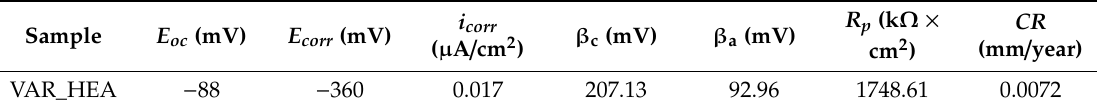
Table 3. Electrochemical parameters of CoCrFeNiMo alloy in the chloride-containing solution (3.5% NaCl) at room temperature.